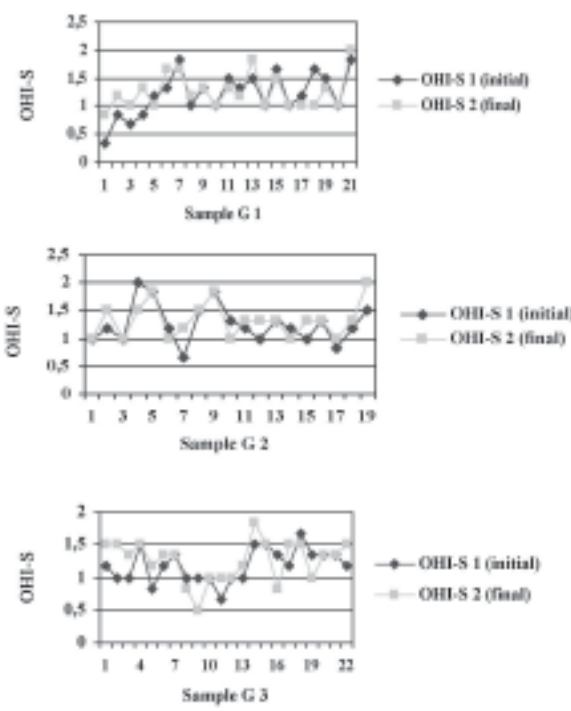
FIGURE 1 - Classification of the OHI-S indexes in the initial (OHI-S 1) and final stages (OHI-S 2) according to the groups in students aged 12 to 14 years. Piracicaba, 2000